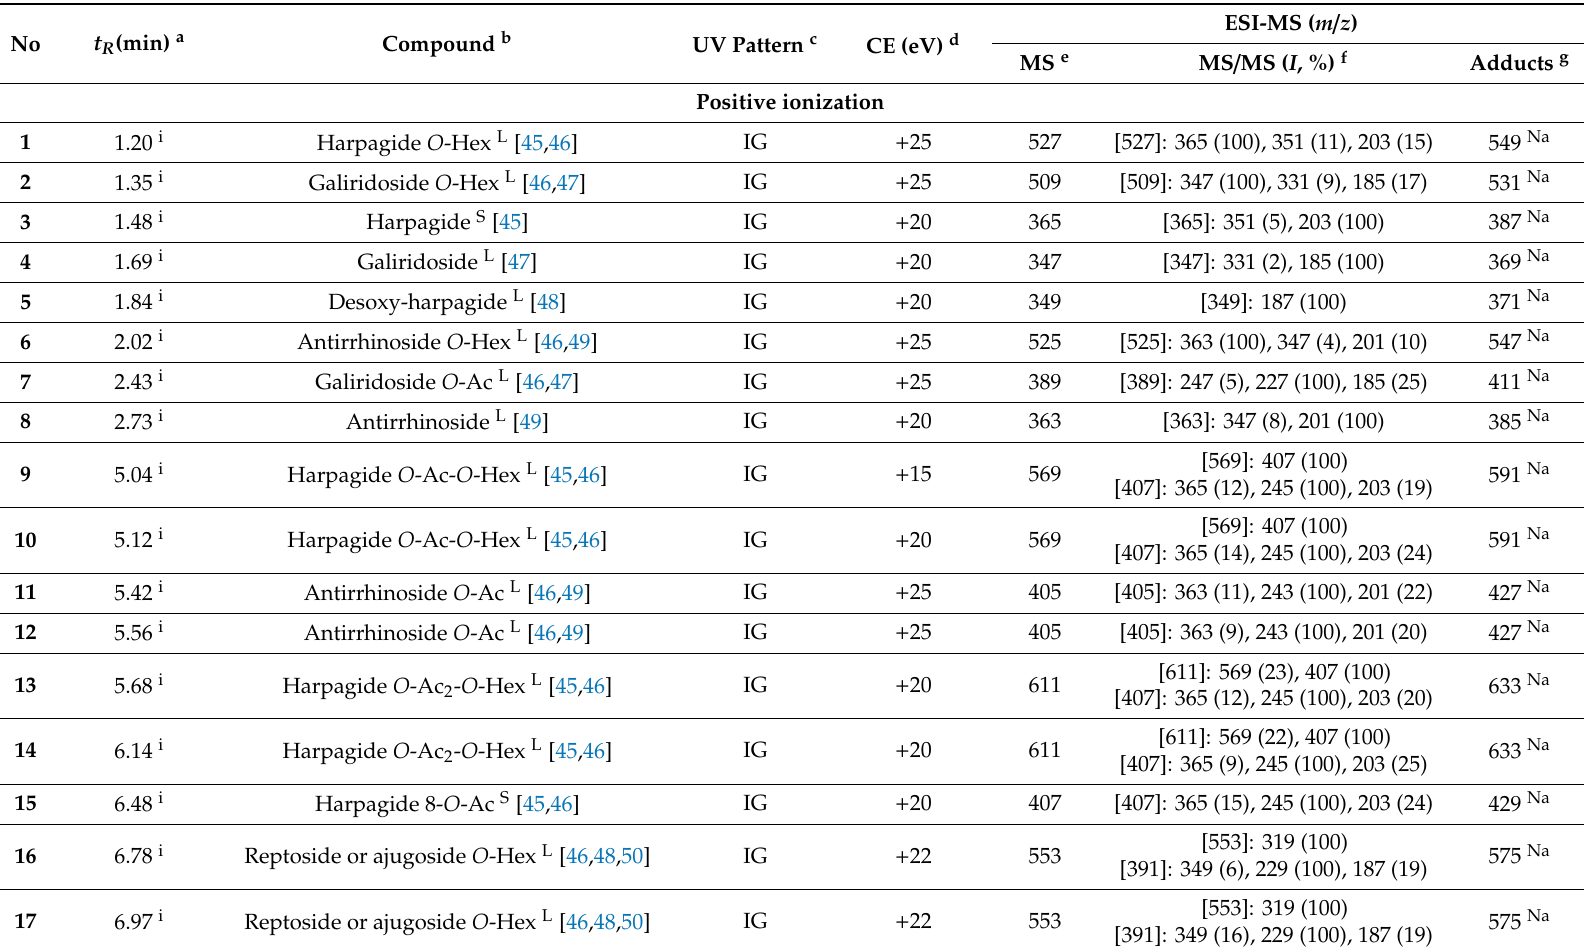
Table 2. Retention times ( t R ), UV- and ESI-MS spectral data of compounds 1 – 90 found in Galeopsis bifida